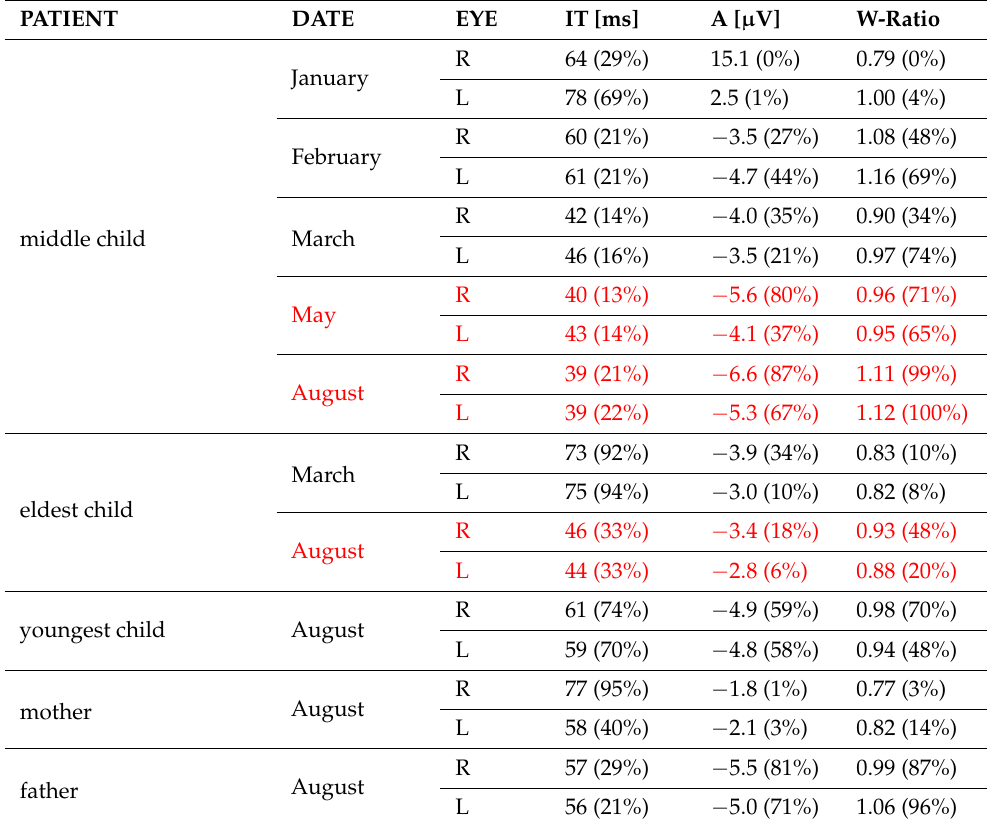
Table 3. Photopic Negative Response Electroretinography performed in the year of diagnosis. Pho- topic Negative wave implicit time (IT), amplitude (A), and W-ratio (W-ratio = (b-p min )/(b-a) [6]). Reference ranges are according to LKC. Values in parentheses are